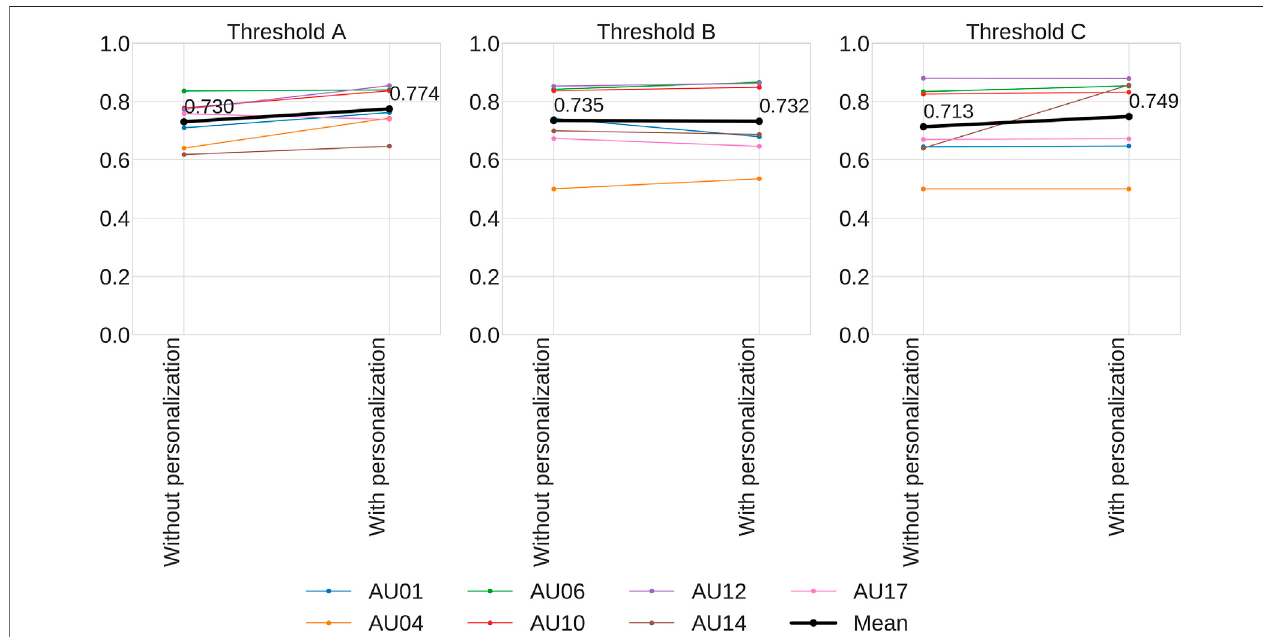
FIGURE 7 | Comparison of 2AFC for occurrence detection between with and without personalization on FERA 2017 Test partition. We evaluated 3 different thresholds. “ Threshold A ” means that the AU is present when the intensity is A-level or higher.